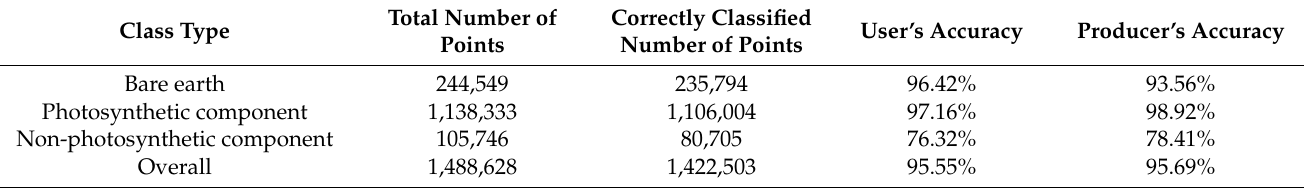
Table 1. Accuracy assessment of pointwise classification result for fused point data.